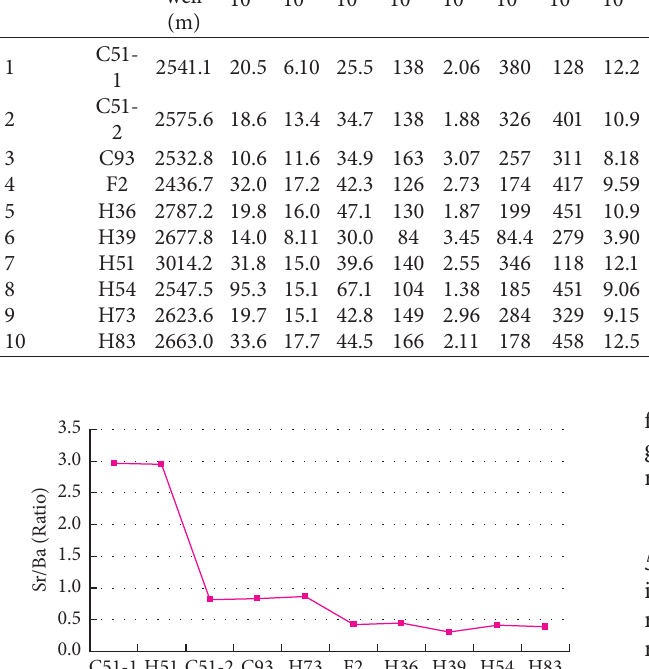
Table 1: The trace elements and paleodepths of 8 mudstones from the Yanchang formation in the Yanchi area. Top depth Number Well of the well